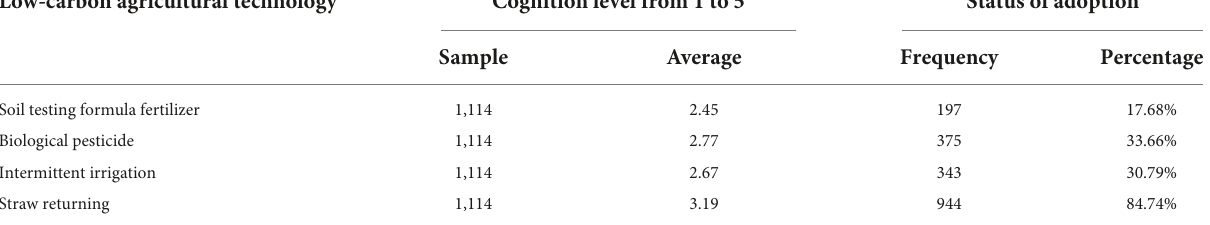
TABLE 3 Rice farmers’ cognition level and adoption of low-carbon agricultural technologies. Low-carbon agricultural